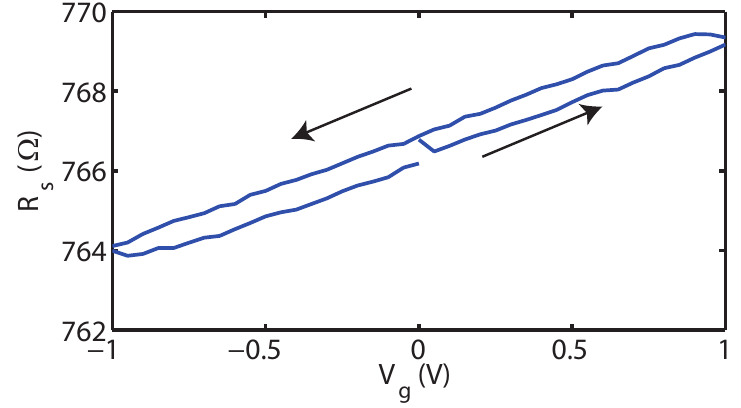
Figure 2. Typical sheet resistance R S plotted against gate voltage V g for a 30 UC La film grown on (LaAlO ) (Sr AlTaO ) . In the given V g range, hysteresis is absent (apart from a 3 0.3 2 6 0.7 small instrumental time delay) and we observe a linear relationship having a positive slope, coinciding with hole (electron) doping for negative (positive) gate voltages. The sweep rate is 50 mV/s, while the polarization temperature is 225 K. The arrows indicate the direction of the evolution of the curves in